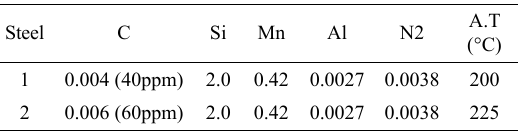
Table 1. Chemical composition in weight % and the critical ageing temperature